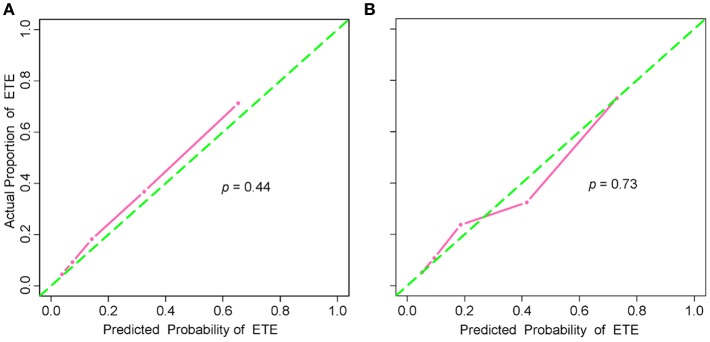
Calibration curves of the radiomic nomogram in the training and validation cohorts. (A) Calibration curve of the radiomic nomogram in the training cohort. The Hosmer-Lemeshow test yielded a non-significant statistic (p = 0.44). (B) Calibration curve of the radiomic nomogram in the validation cohort. The Hosmer-Lemeshow test also yielded a non-significant statistic (p = 0.73). Calibration curves describe the model's calibration in term of agreement between the predicted probability of ETE and observed positive proportion of ETE. The green dashed line represents perfect performance, while the pink solid line presents the actual performance of the radiomic nomogram. ETE, extrathyroidal extension.